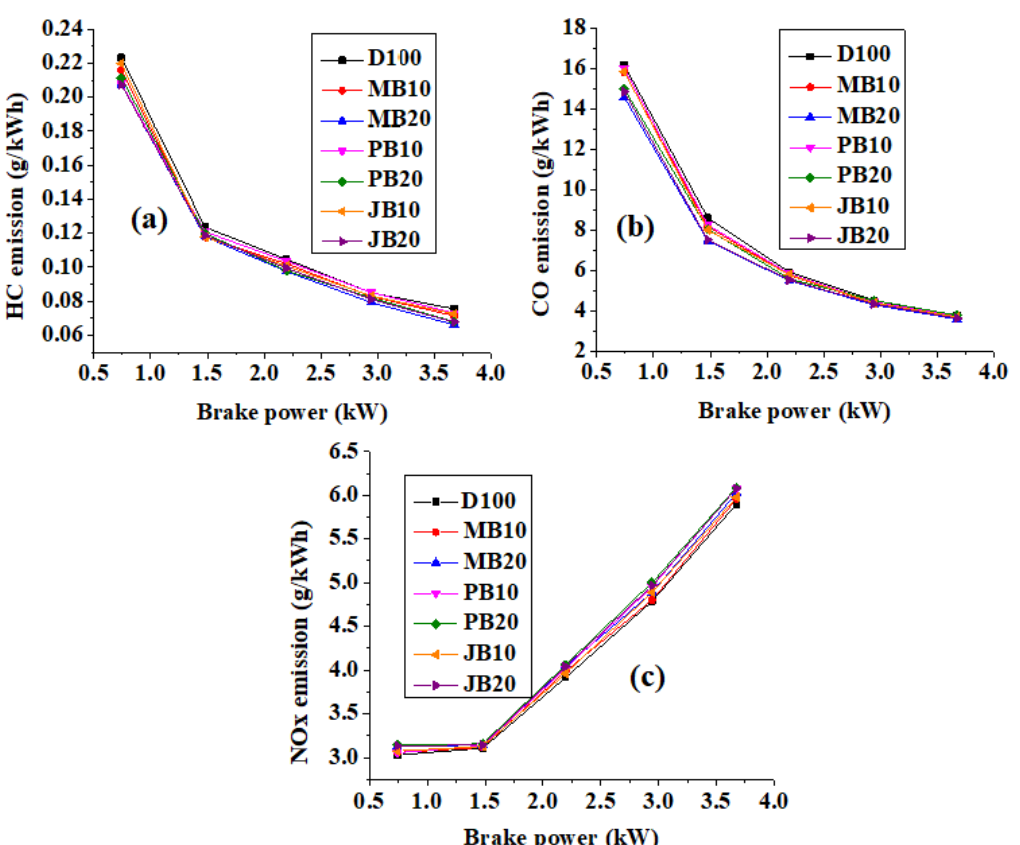
Figure 6. ( a ) Comparison of HC emissions with respect to engine loading for microalgae, jatropha, and polanga biodiesel fuels. ( b ) Comparison of CO emissions with respect to engine loading for microalgae, jatropha, and polanga biodiesel fuels. ( c ) Comparison of NOx emissions with respect to engine loading for microalgae, jatropha, and polanga biodiesel fuels.